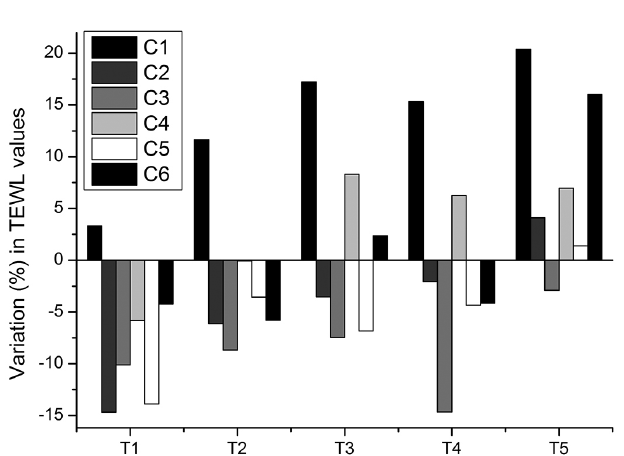
FIGURE 2 - Percentage changes in TEWL values calculated before and 1, 2, 3, 4 and 5 hours after topical application of formulations. C1 = Untreated area control; C2 = Vehicle; C3 = Vehicle + 1,0% EHG001; C4 = Vehicle + 1.0% solvents; C5 = Vehicle + 3.0% EHG001; C6 = Vehicle + 3.0% solvents; Basal = measurement performed before topical application. T1, T2, T3, T4 e T5 = measurement performed after 1, 2, 3, 4 e 5 h respective topical